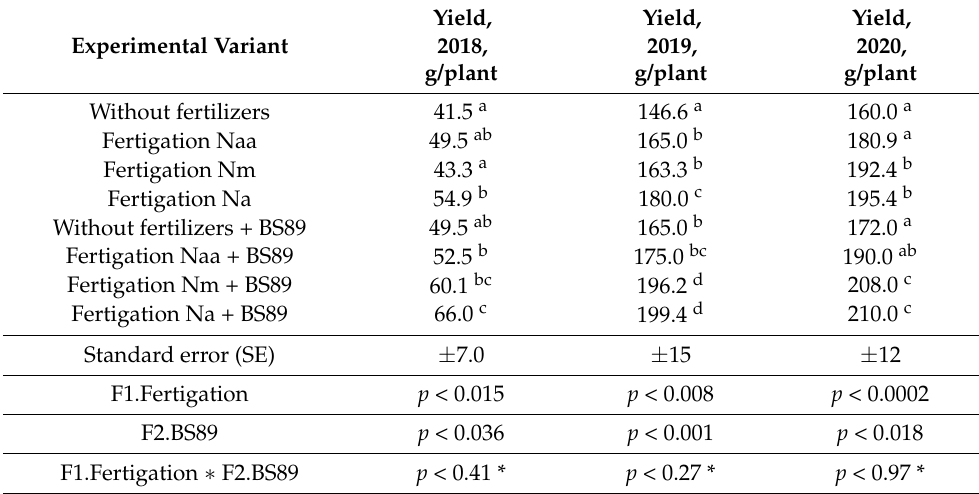
Table 5. Yield of berries of cv. Troitskaya strawberry plants and ANOVA